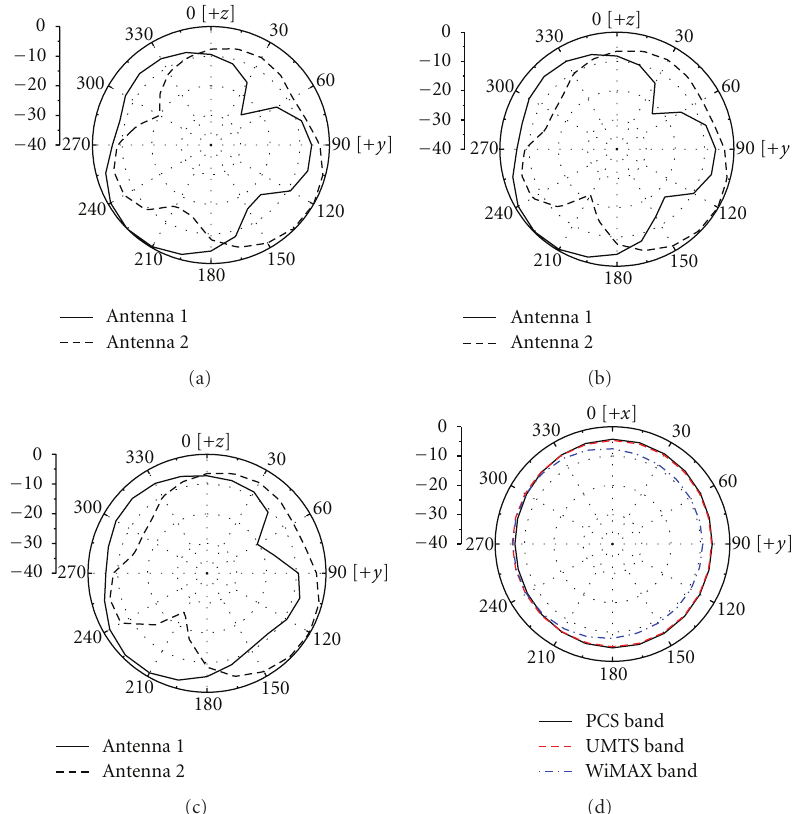
Figure 6: Measured radiation patterns: (a) yz -plane, PCS band, (b) yz -plane, UMTS band, (c) yz -plane, WiMAX band, and (d) xy -plane, PCS/UMTS/WiMAX bands when Antenna 1 is